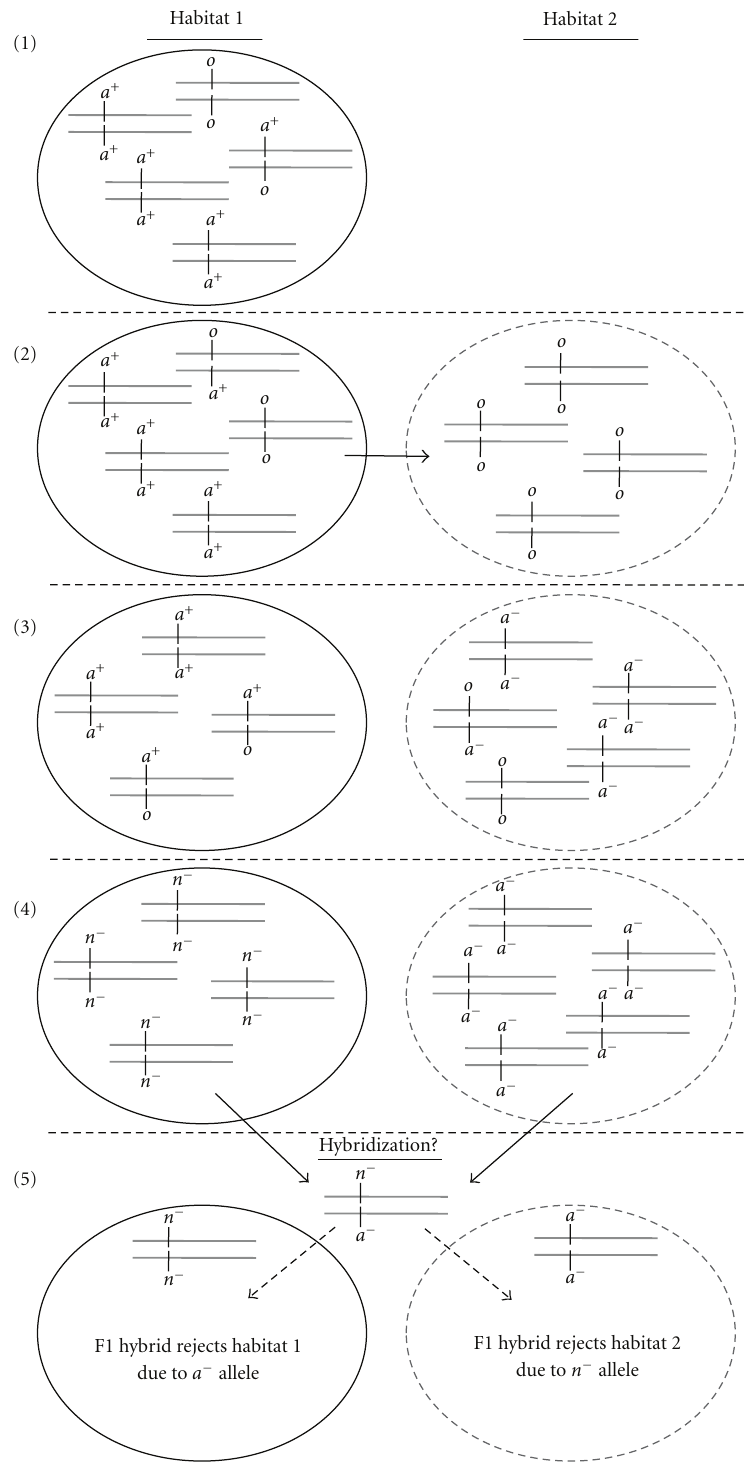
Figure 1: Illustration of model 1 based on intermediate null allele (see Table 1 for model description). Numbered steps of model (1–5) are separated by dashed lines and ordered vertically. Individuals are represented by chromosome pairs as grey bars; avoidance locus is marked by solid black tick mark on grey chromosome. Alleles at avoidance locus are labeled as follows: a + : preference for ancestral habitat; o : recessive null allele (i.e., no preference or avoidance); a − : avoidance for ancestral habitat; n − : avoidance for novel habitat. Arrow depicts shift from ancestral habitat 1 to novel habitat